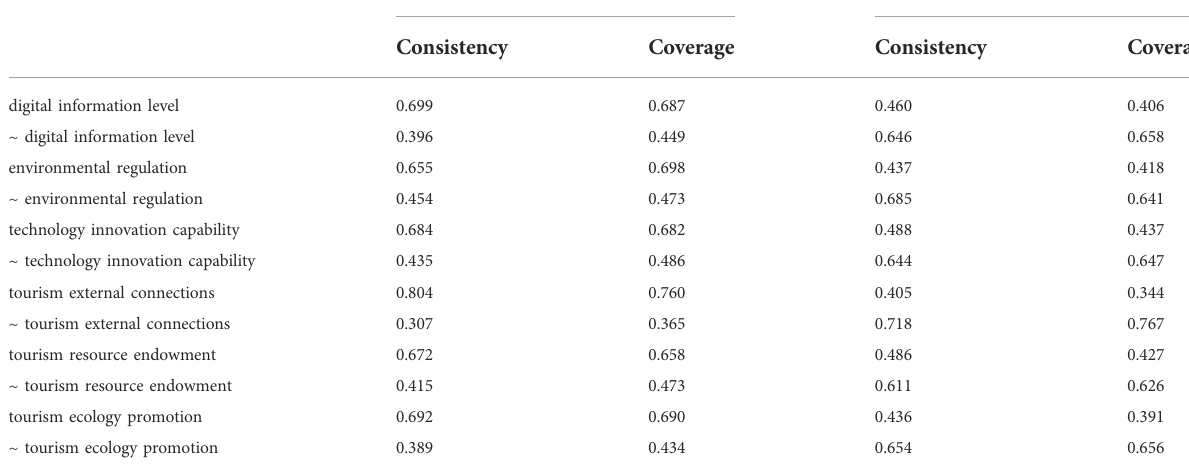
TABLE 3 Necessity analysis of single conditions.